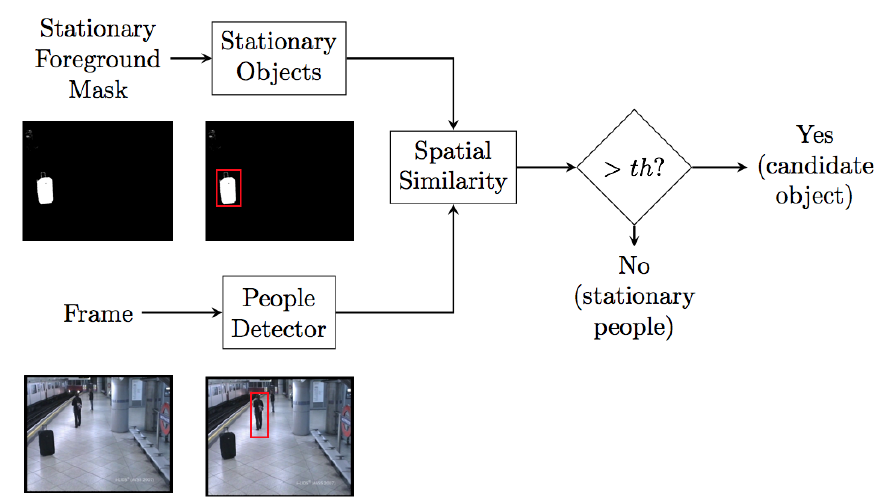
Figure 6. Block diagram of the candidate generation module. Stationary objects and people detection blobs are independently extracted and then spatially compared. If a stationary object overlaps with people detection, it is considered as a static person, otherwise the object is a potential abandoned object